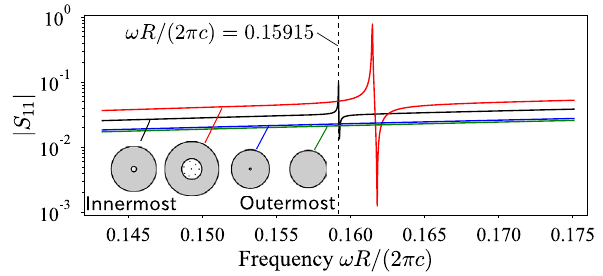
Figure 4. Dipolar component spectrum of the scattering matrix S for each rubber-lead rod.